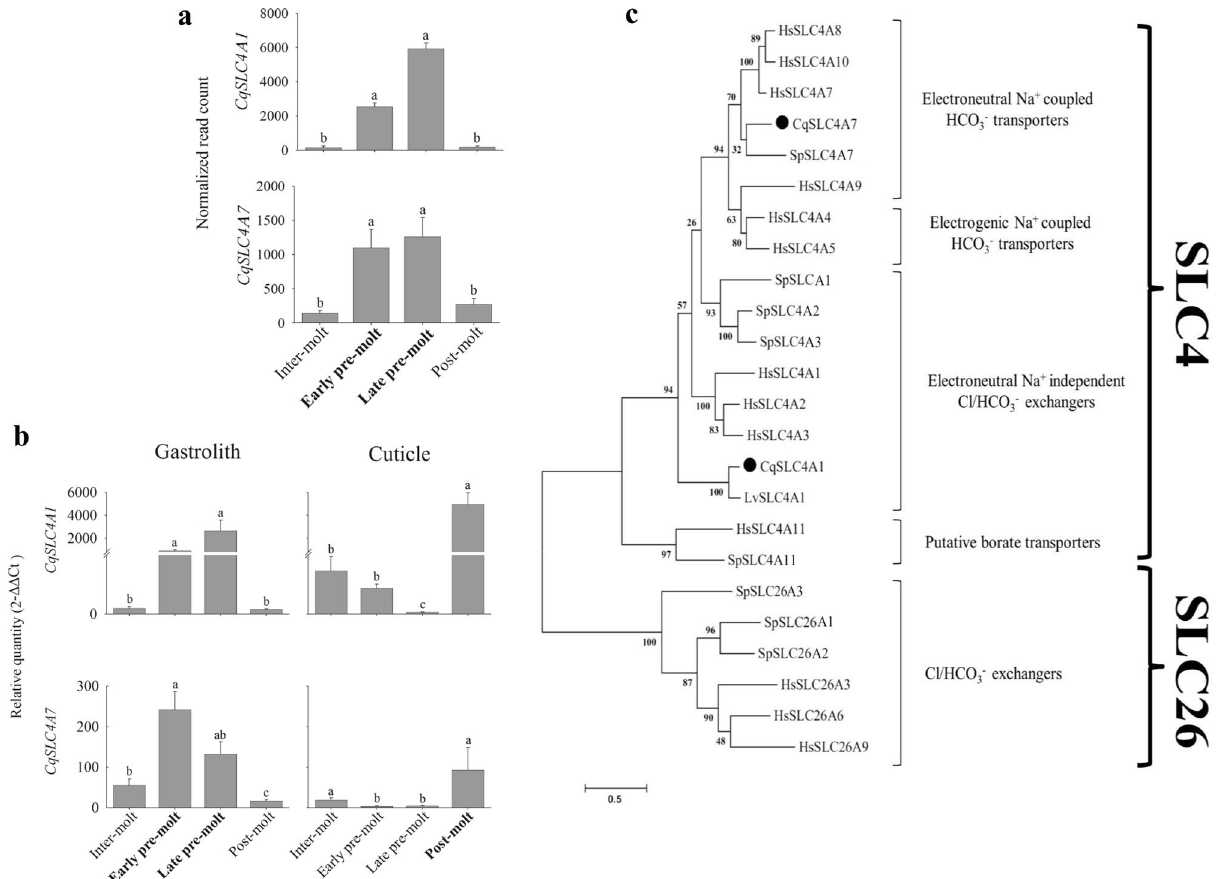
Figure 1. Gene expression levels of the newly found SLC4 transporters during the molt stages correlate with the mineralization patterns of distinct cuticular structures. ( a ) In-silico temporal expression of CqSLC4A1 and CqSLC4A7 found in the molt-related transcriptomic library. Data are means ± s.d.; inter-molt (n = 2), early pre- molt (n = 4), late pre-molt (n = 3) and post-molt (n = 3). Different letters represent groups that are statistically significantly different (p-value < 0.05). ( b ) Relative levels of CqSLC4A1 (top) and CqSLC4A7 (bottom) in the gastrolith-forming epithelium (left) and carapace cuticle-forming epithelium (right) at four molt stages, as determined by qPCR. Molt stages in which the bulk of mineralization occurs are shown in bold typeface for each cuticular structure. Data are means ± s.d., n = 5. Different letters represent groups that are significantly different (p < 0.05). ( c ) Maximum likelihood tree of SLC4 transport proteins from the decapod crustacean C. quadricarinatus (Cq) discovered in the present study and marked with a dot, the decapod crustacean L. vannamei (Lv), the bony coral S. pistillata (Sp), and H. sapiens (Hs). Bootstrap test (n = 1000) results are shown on each node